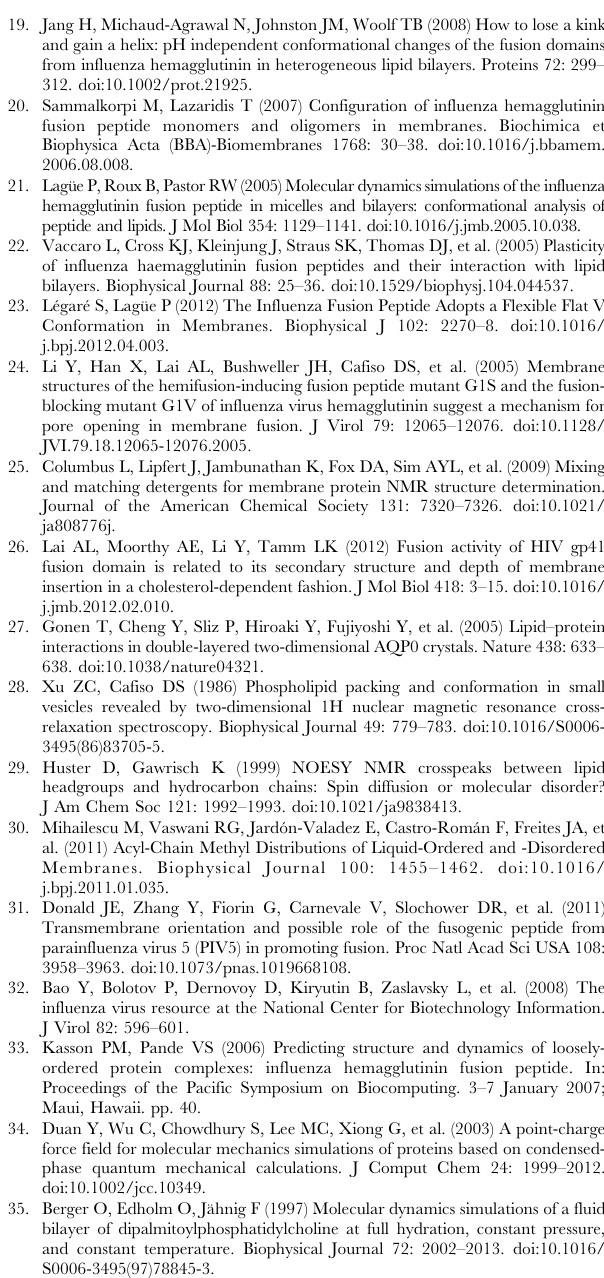
Table S1 Time constants (ns 2 1 ) for the autocorrelation functions in Fig. S2 after best fit to a double exponential a*ex- p(b*x) + c*exp(d*x) using Matlab. Upper and lower bounds represent 95% confidence intervals were obtained using bootstrap